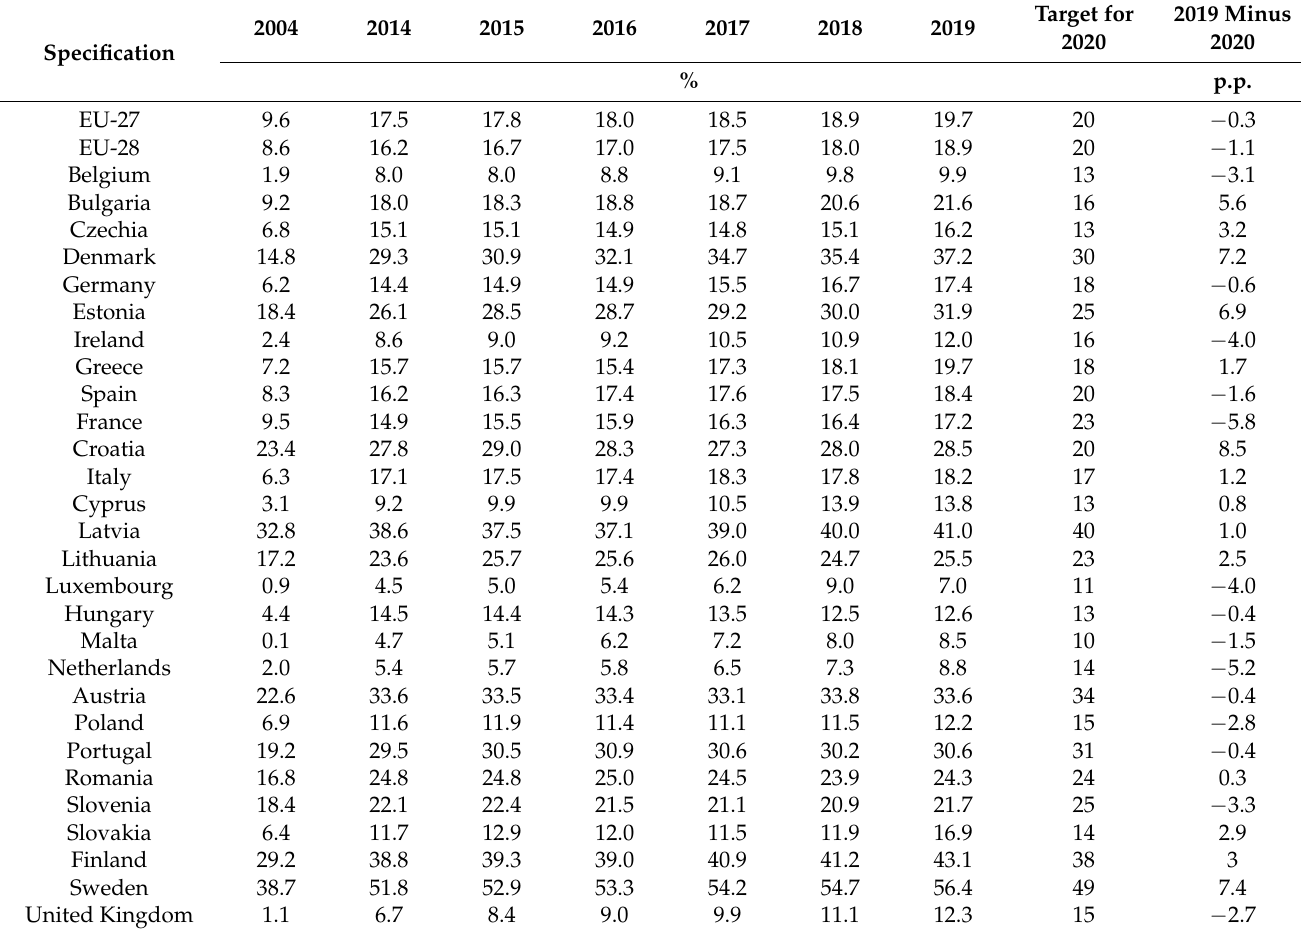
Table 1. The share of RES in total energy production in countries belonging to the EU